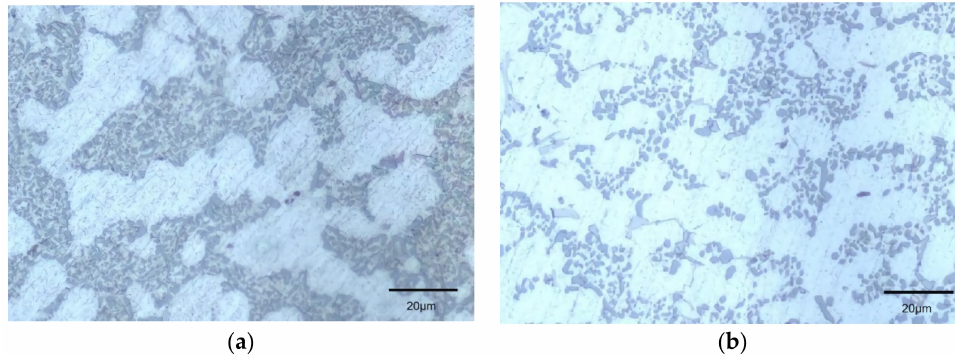
Figure 2. Metallurgical microstructure of AlSi10MgMn alloy in ( a ) cast state; ( b ) T6 heat-treated